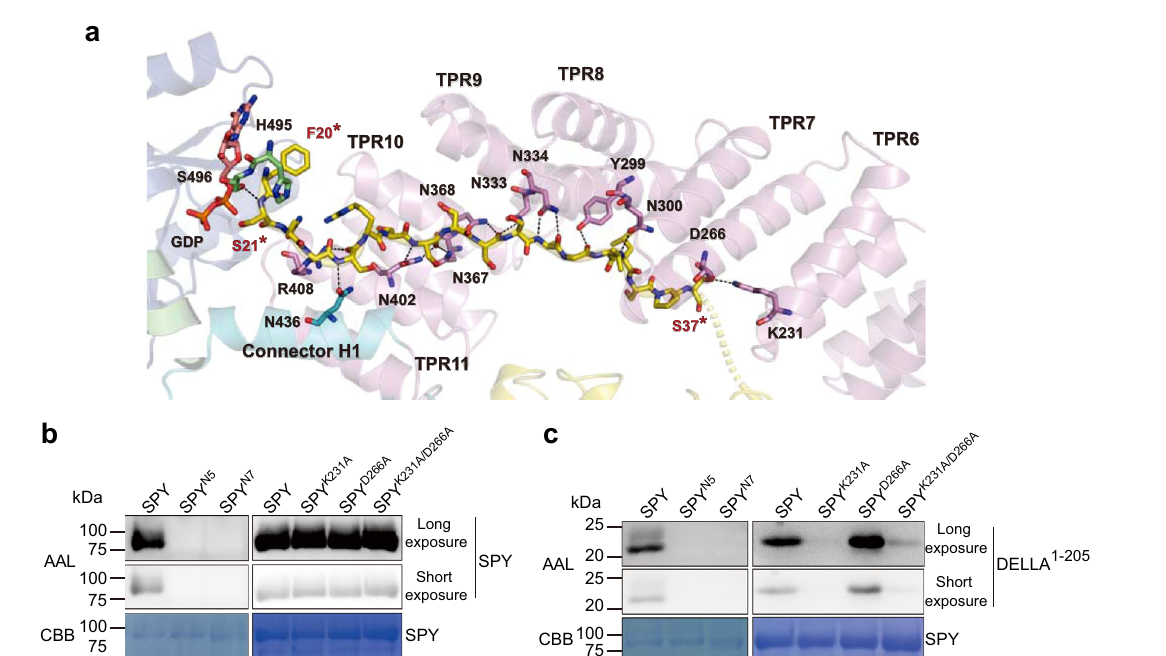
Fig. 3 | Substrate binding in SPY. a Close-up view of the substrate binding in the ‘ catalytic SPY ’ /GDP/ ‘ substrate SPY ’ complex. The ‘ catalytic SPY ’ molecule is shown as cartoon. Residues of interest and GDP in the ‘ catalytic SPY ’ are shown as sticks andlabeledinblack.Thesubstrateloopinthe ‘ substrateSPY ’ moleculeisshownas sticks. F20* and S21* in the substrate loop are labeled in red. Black dotted lines indicate hydrogen bonds. The color coding is the same as in Fig. 2a. b Self- fucosylation of SPY variants. SPY N5 contains N300A, N334A, N367A, N368A and N402A. SPY N7 is SPY N5 combined with R408A and N436A. Upper panel (long exposure) and middle panel (short exposure) show western blotting with